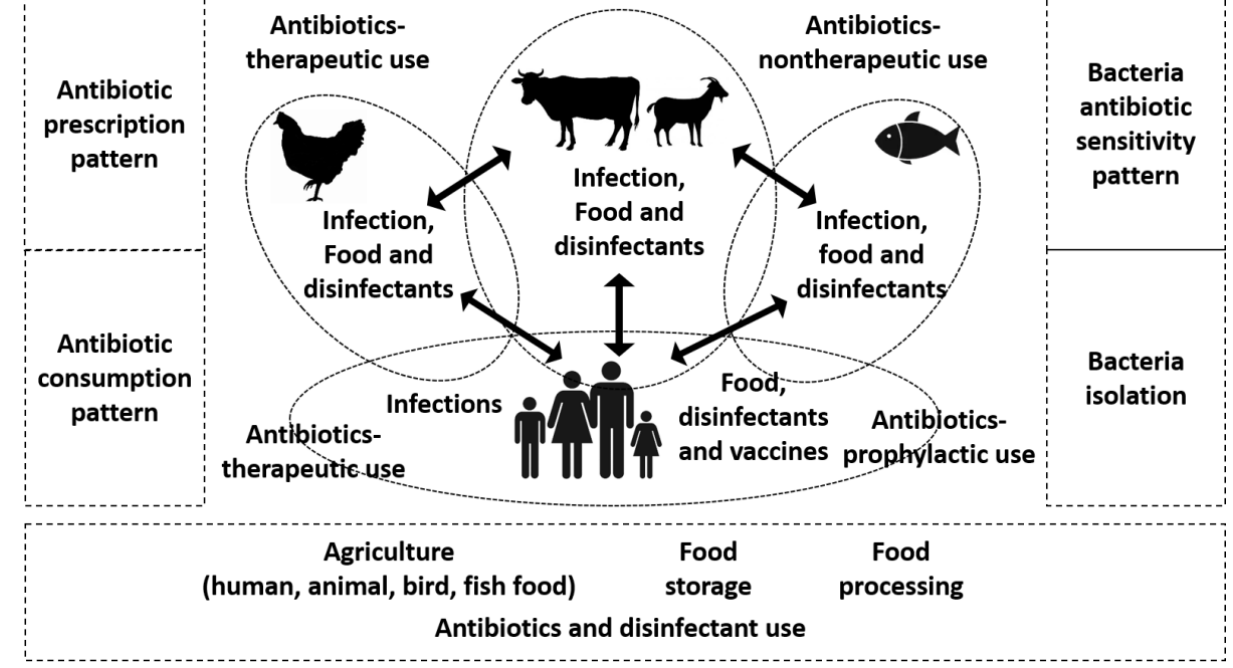
Figure 1. The proposed conceptual model of multihost surveillance for bacterial infections and antibacterial